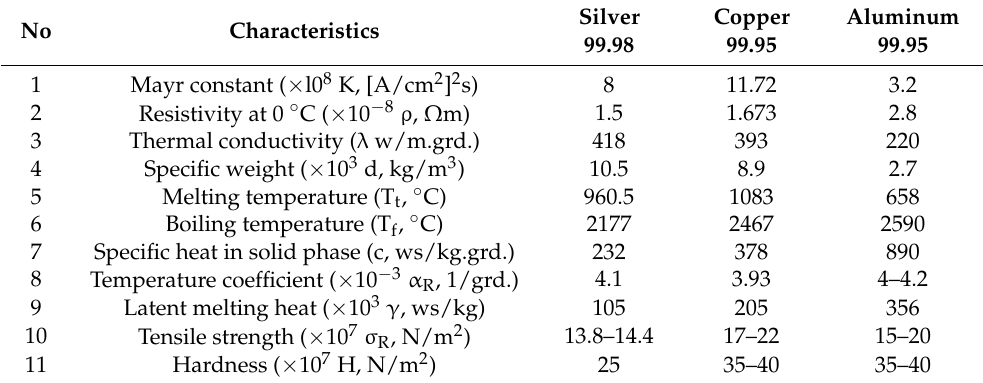
Table 1. Electrical and thermal characteristics of the materials used to build the fuse. No